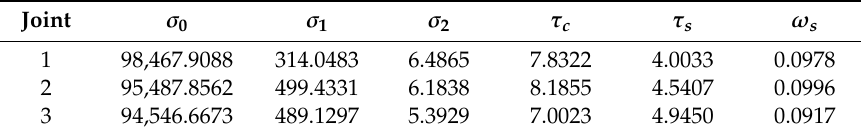
Table 1. Identified parameters of three-joint manipulator friction model.